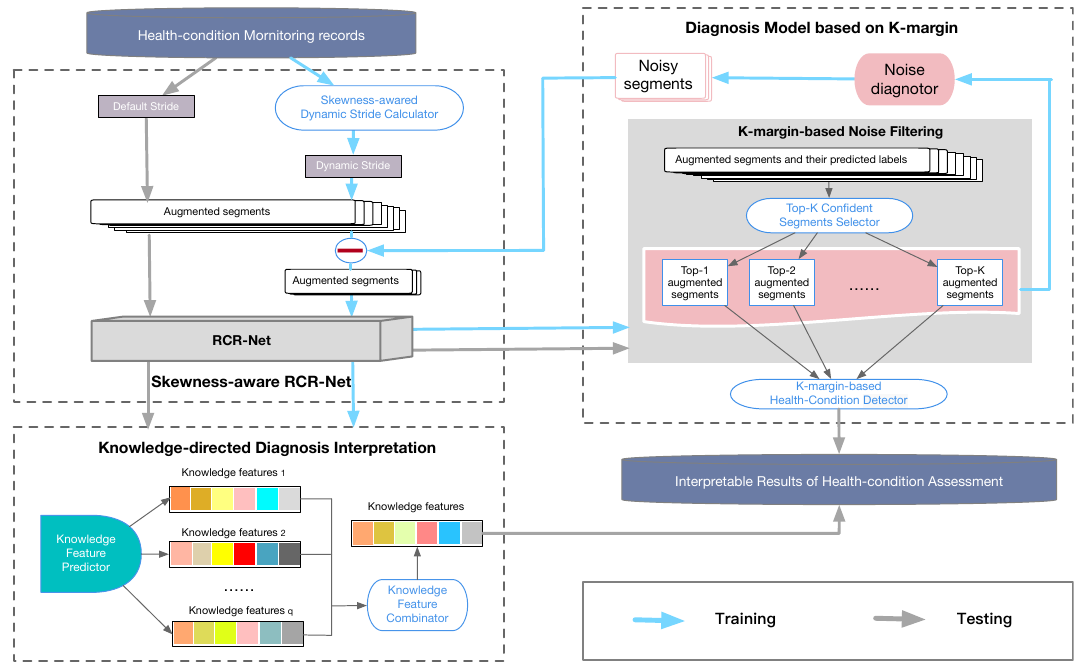
Figure 2. The framework of the k-margin-based interpretable